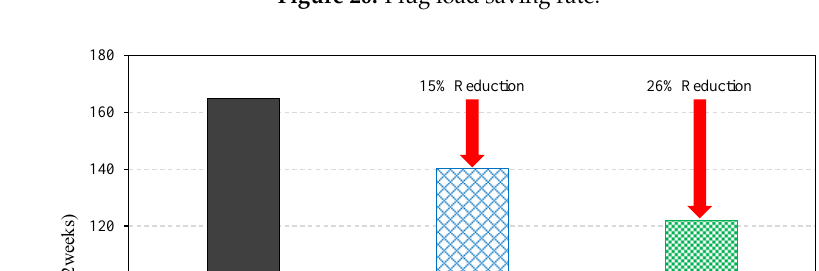
Figure 20. Plug load saving rate.